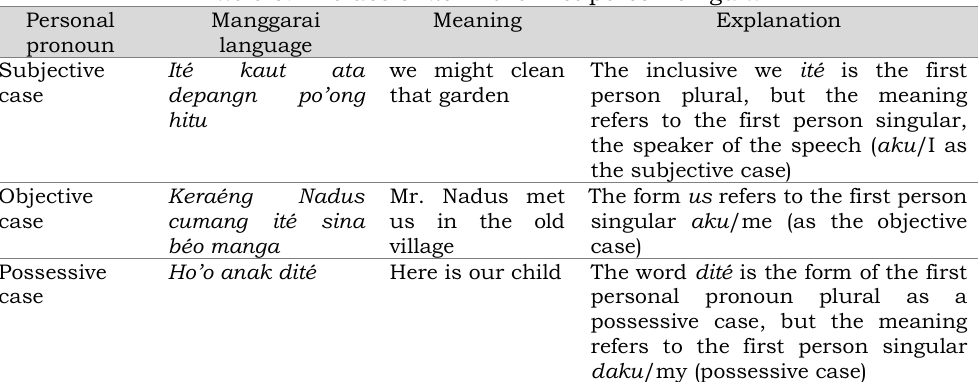
Table 6. The use of ité in the first person singular